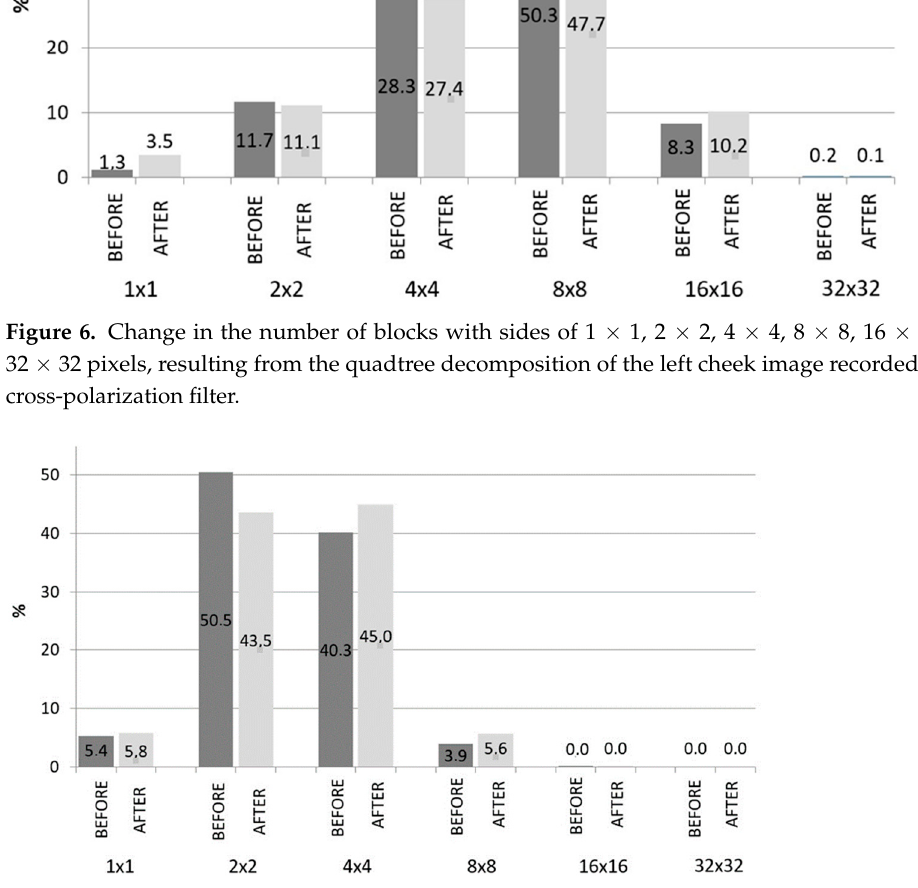
Figure 7. Change in the number of blocks with sides of 1 x 1, 2 x 2, 4 x 4, 8 x 8, 16 x 16 and 32 x 32